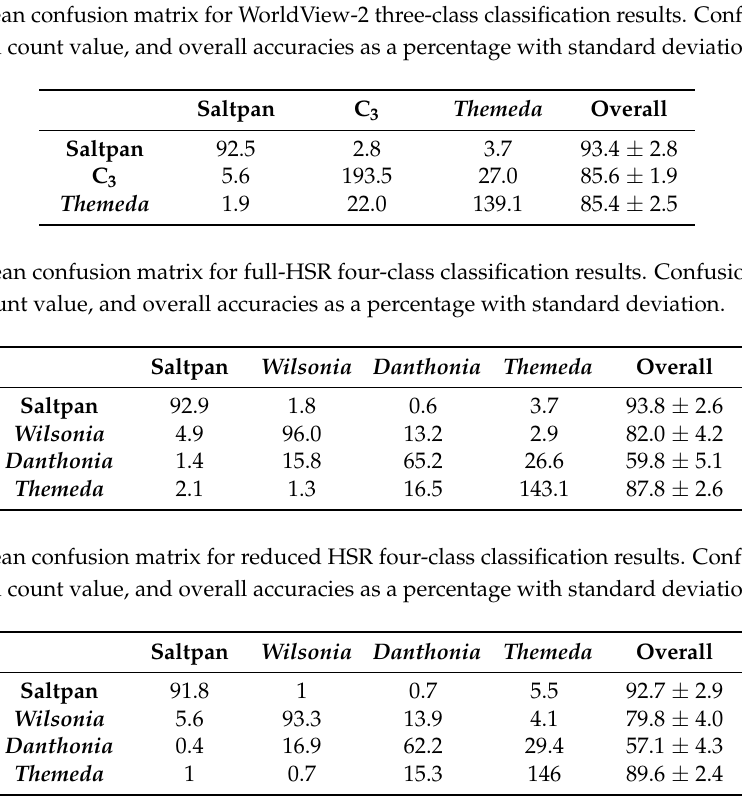
Table A7. Mean confusion matrix for Landsat OLI four-class classification results. Confusion values are given as a count value, and overall accuracies as a percentage with standard deviation.